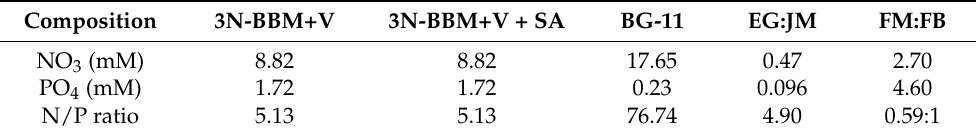
Table 1. Nitrate, phosphate and N/P ratio of media used in green stage